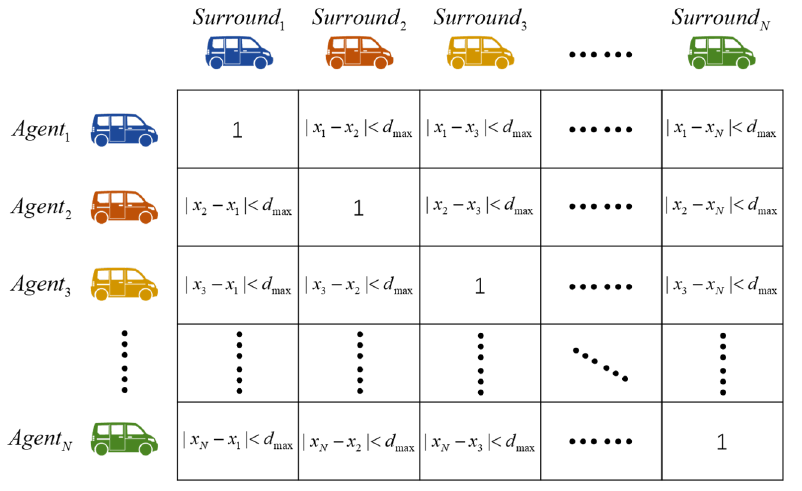
Figure 2. The schematic diagram of the correlation matrix setting. Each row in the matrix represents the correlation between a vehicle and all other vehicles, specifically the logical values of 0 and 1, where 0 represents the actual distance greater than the set distance, and 1 represents the actual distance less than the set